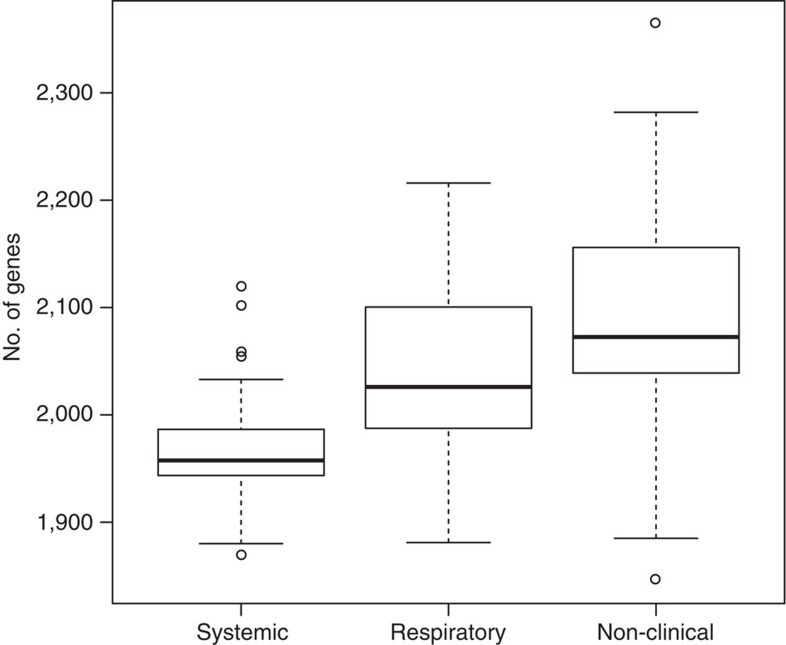
Genome size differences in isolates of different clinical phenotype.The number of genes in 153 S. suis isolates isolated from pigs in the United Kingdom. Isolates were classified as non-clinical (isolated from the nasal passage) n=62, systemic (disease-causing and isolated from the brain, blood or joints) n=52 or respiratory (disease-causing and isolated from the lungs) n=39. Boxes show the medians and upper and lower quartiles; whiskers show the most extreme values within 1.5 times the interquartile range.